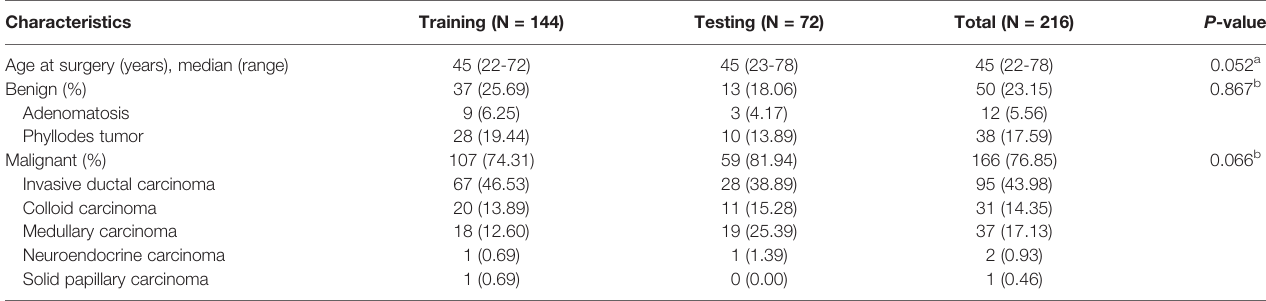
TABLE 1 | Basic clinical information of enrolled